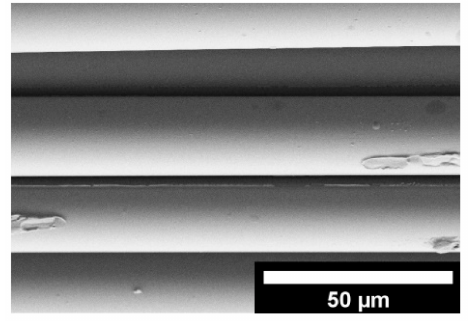
Figure 6. SEM image of